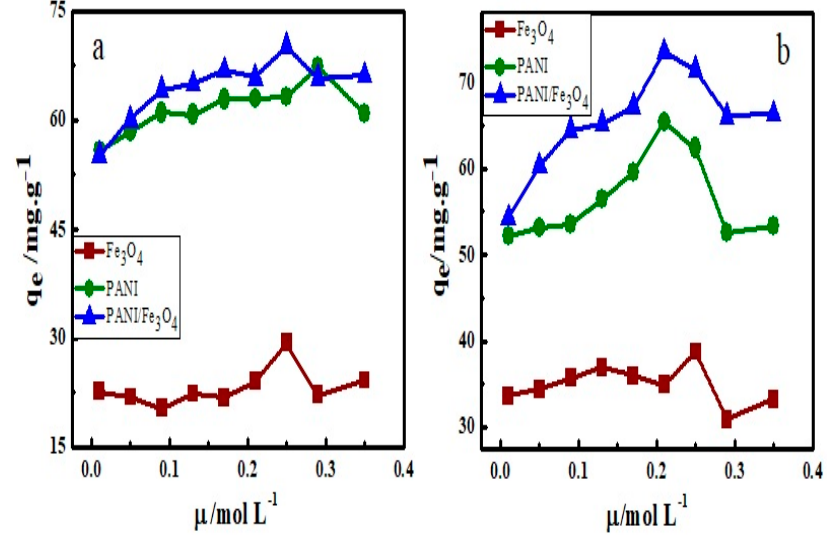
Figure 9. The effect of ionic strength of ( a ) Na 2 SO 4 .7H 2 O and ( b ) CaCl 2 .2H 2 O on adsorption of AB40 onto Fe 3 O 4 , PANI and PANI/Fe 3 O 4 composite. onto Fe / Fe 3 O 4 , PANI and PANI 3 O 4